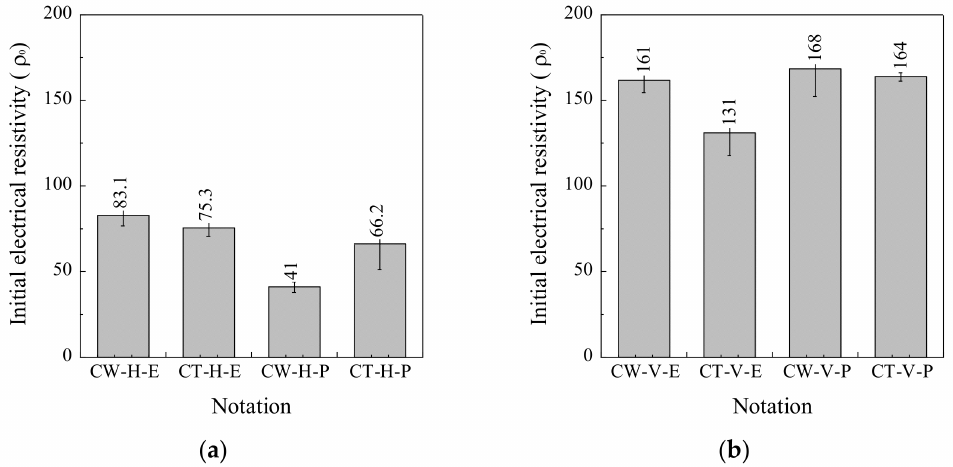
Figure 9. Effects of materials, arrangement, and connector on the initial electrical resistivity of SCA: ( a ) H series; ( b ) V series.